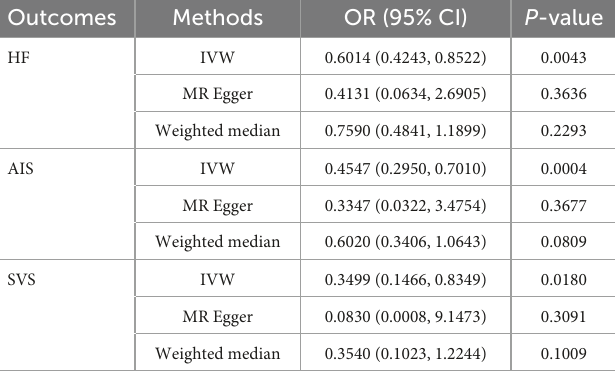
TABLE 1 Causal effects of dried fruit intake on HF, AIS, and SVS evaluated by IVW method, MR Egger method, and weighted median method. Outcomes